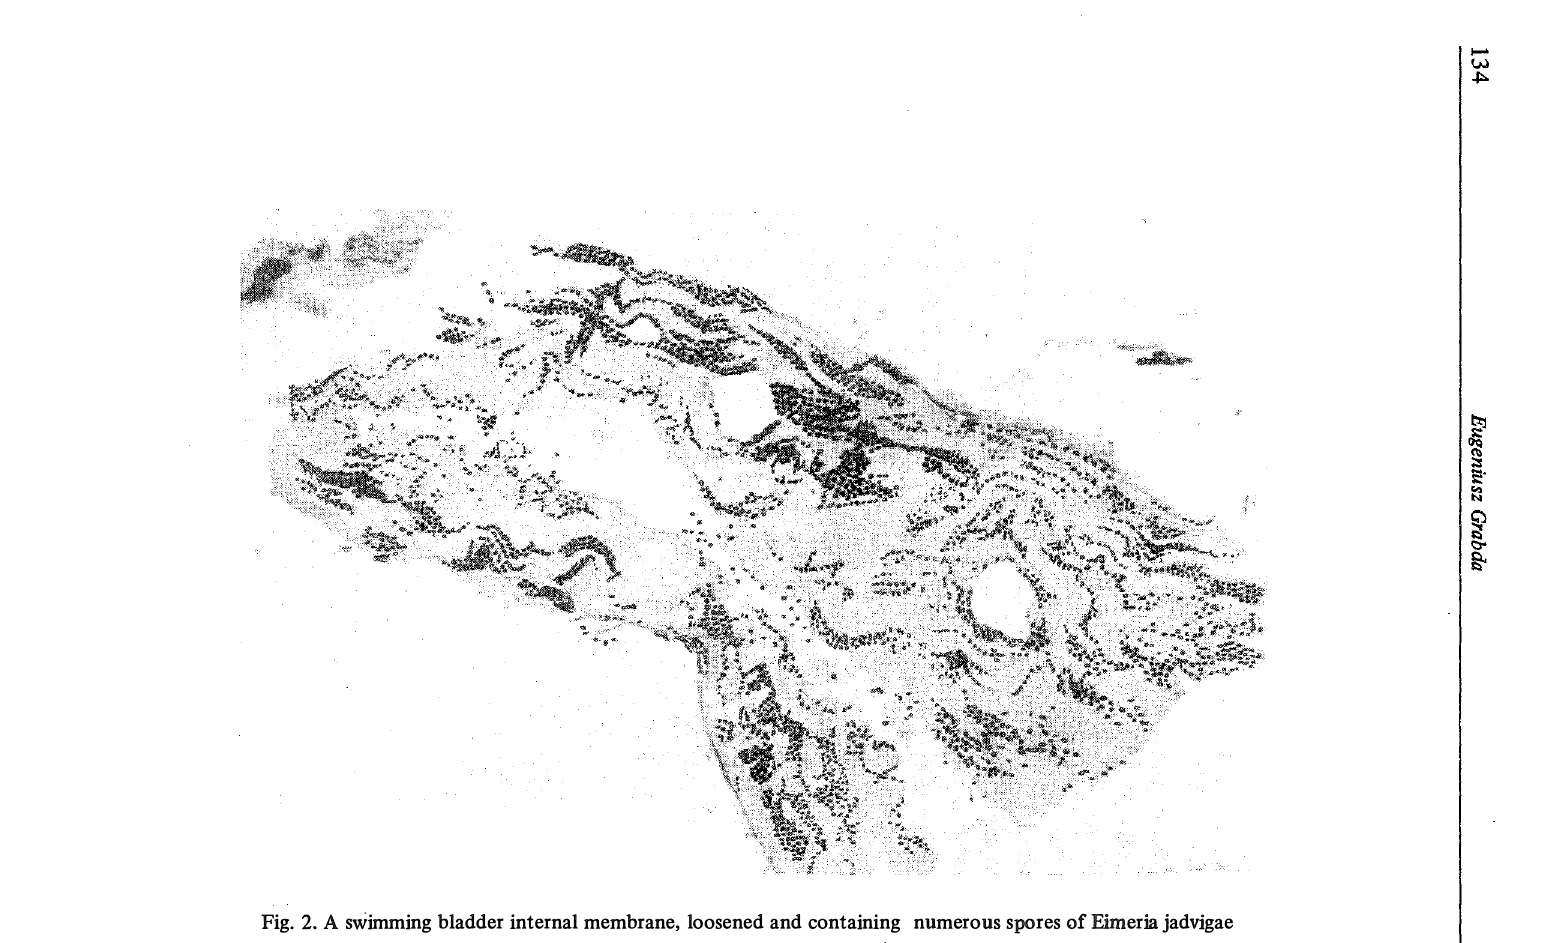
Fig. 2. A swimming bladder internal membrane, loosened and containing numerous spores of Eirneria